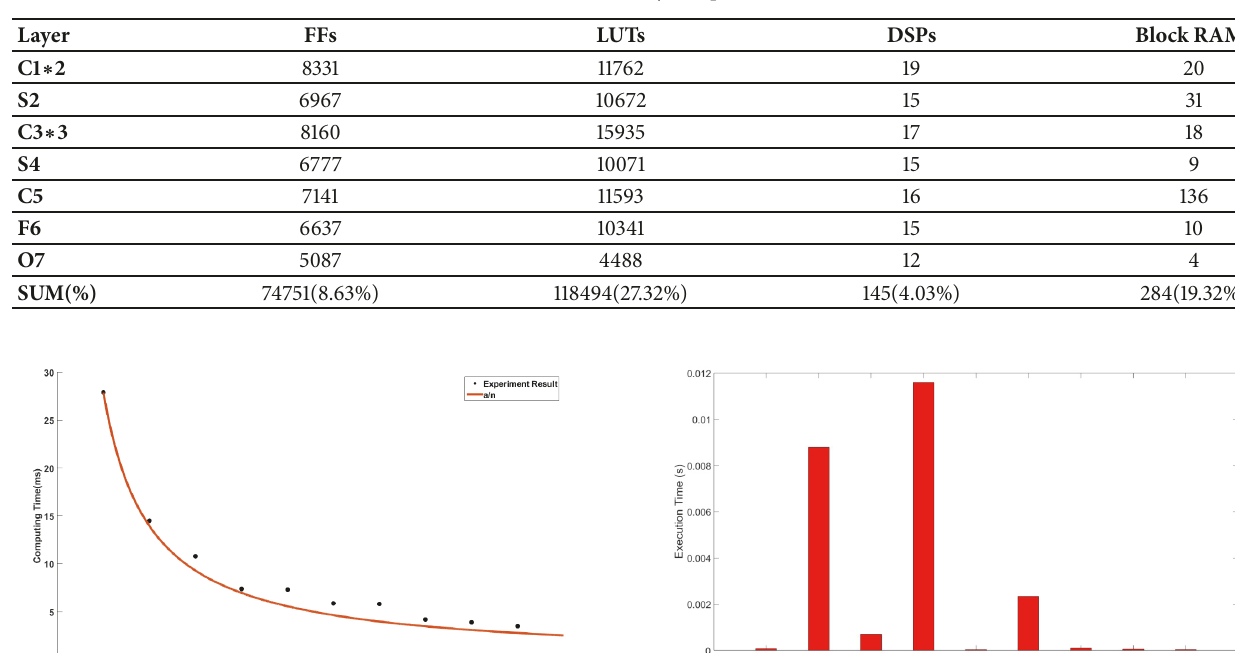
Table 8: The resources of every compute unit on FPGA.